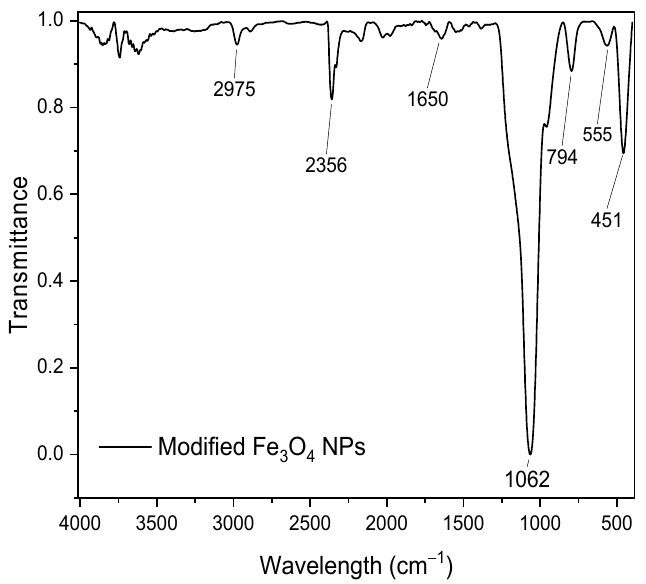
Figure 11. FTIR patterns of modified Fe 3 O 4 NPs.